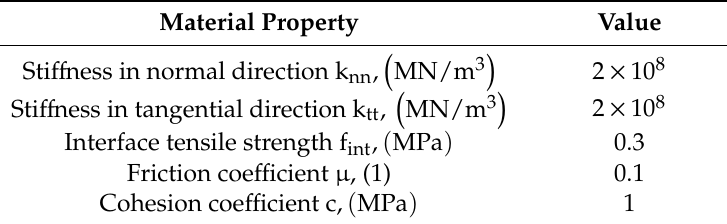
Table 8. Interface layer material data for FEM calculations.